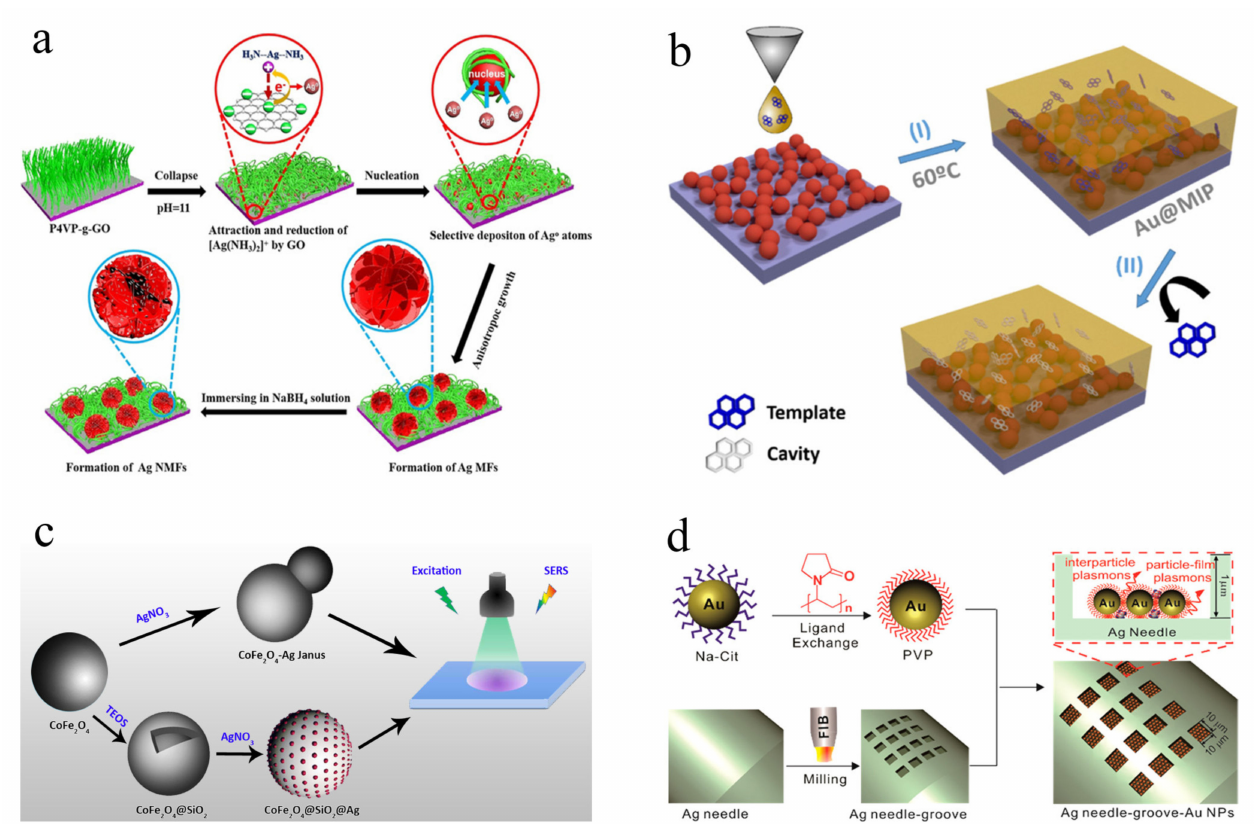
Figure 4. Schematic procedure for fabricating of 3D Ag MFs and Ag NMFs on P4VP-g-GO films ( a ). © 2022 Wiley-VCH Verlag GmbH & Co. KGaA. Adapted with permission from [64]. Schematic illustration of preparation of Au@MIP film ( b ). © 2022 American Chemical Society. Adapted with permission from [31]. Schematic synthesis of CoFe 2 O 4 /Ag substrate ( c ). © 2022 American Chemical Society. Adapted with permission from [107]. Schematic synthesis of Au-G-AgNs ( d ). © 2022 American Chemical Society. Adapted with permission from